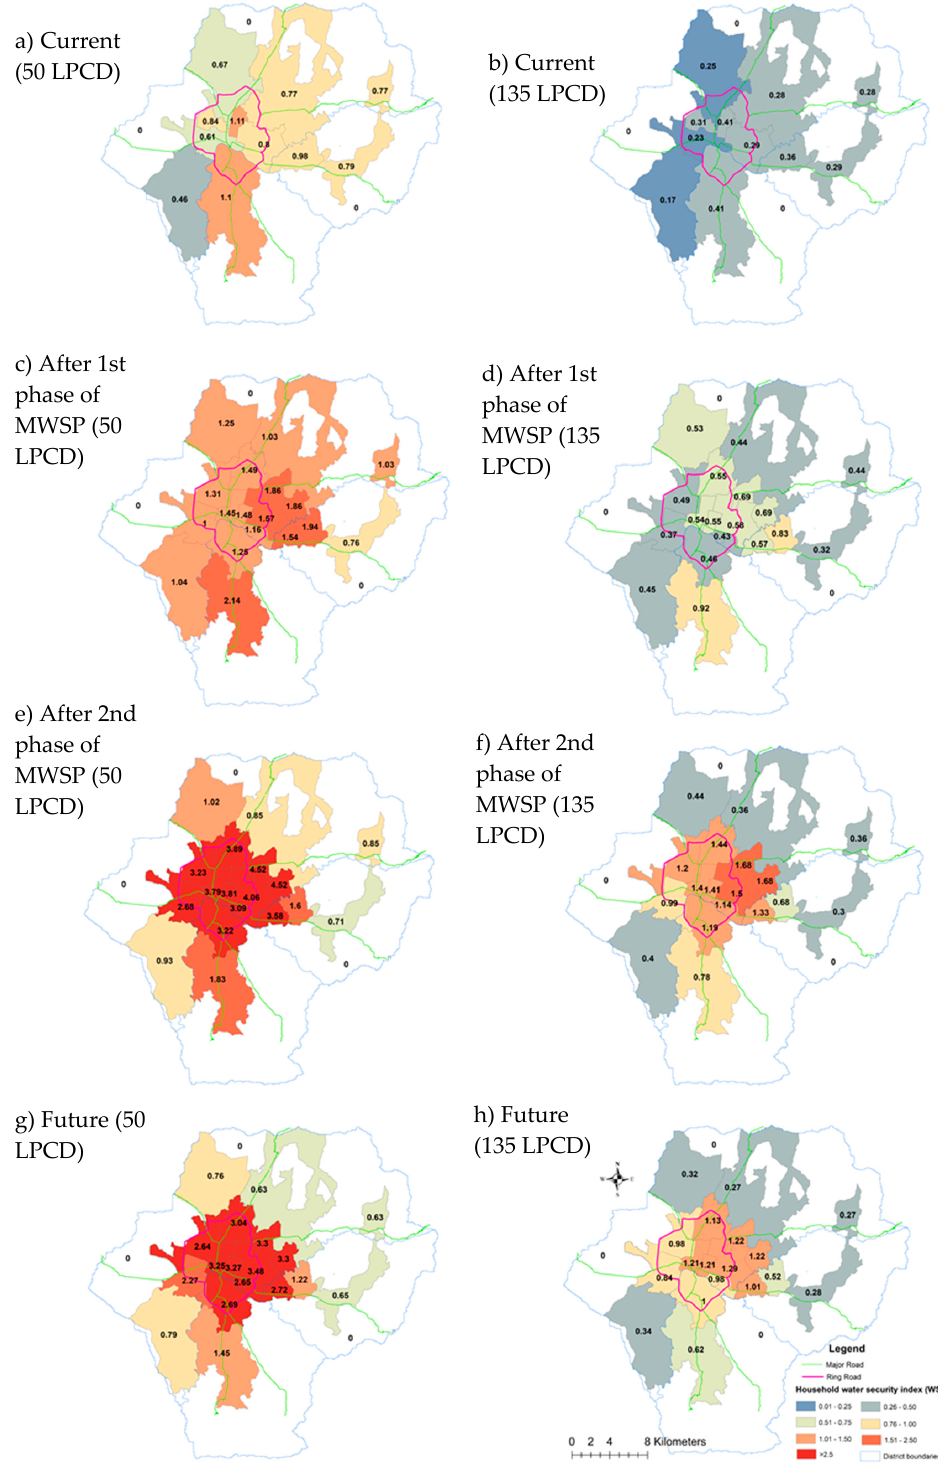
Figure 5. Household water security index: ( a ) current (basic), ( b ) current (economic growth), ( c ) after first phase of mwsp (basic), ( d ) after first phase of mwsp (economic growth), ( e ) after second phase of mwsp (basic), ( f ) after second phase of mwsp (economic growth), ( g ) future (basic), ( h ) future (economic growth).